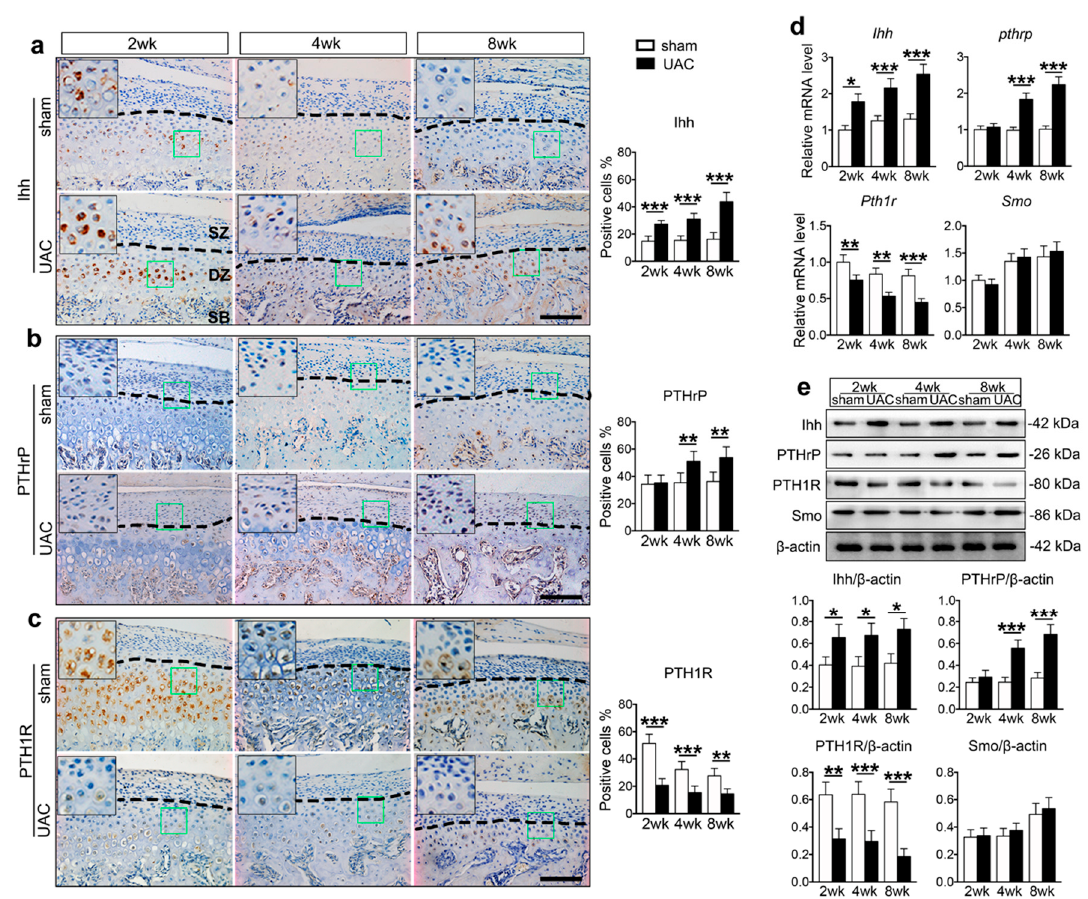
Figure 2. The changes of Indian hedgehog (Ihh) and parathyroid hormone receptor 1 (PTHrP) expression levels in TMJ cartilage of the UAC treated rat. ( a – c ) Representative sagittal central sections and the quantification of the positive cells with immunohistochemical staining in UAC and sham TMJ cartilage from 2, 4, and 8 weeks. The green box regions in the images were magnified at the top left corner. Black dotted lines distinguish the superficial and deep zone chondrocyte. SZ , superficial zone. DZ , deep zone. SB , subchondral bone. Magnification, 200 × . Scale bar, 100 µ m. n = 6. ( d ) The mRNA expression levels of Ihh , Pthrp , Smo , and Pth1r in the UAC and sham TMJ cartilage at 2, 4, and 8 weeks. n = 3. ( e ) Western blot of pure cartilage tissues harvested from TMJ for Ihh, PTHrP, Smo, and PTH1R and the related quantification. n = 3. Results are represented as the mean ± SD. * p < 0.05, ** p < 0.01, *** p < 0.001.